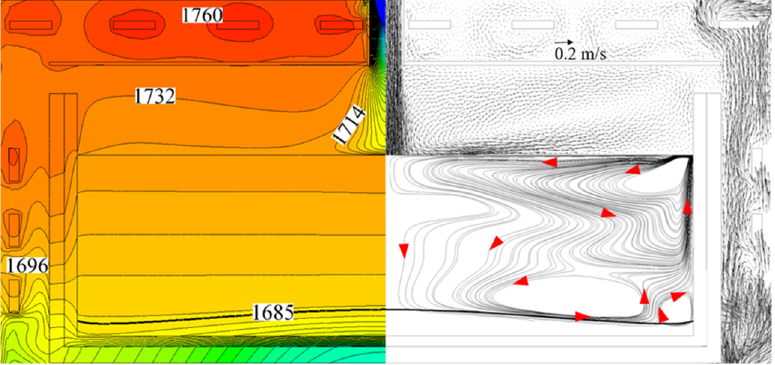
Figure 3. Temperature field ( left ), and flow velocity vector and streamline ( right ) when the solidification fraction is 10%.